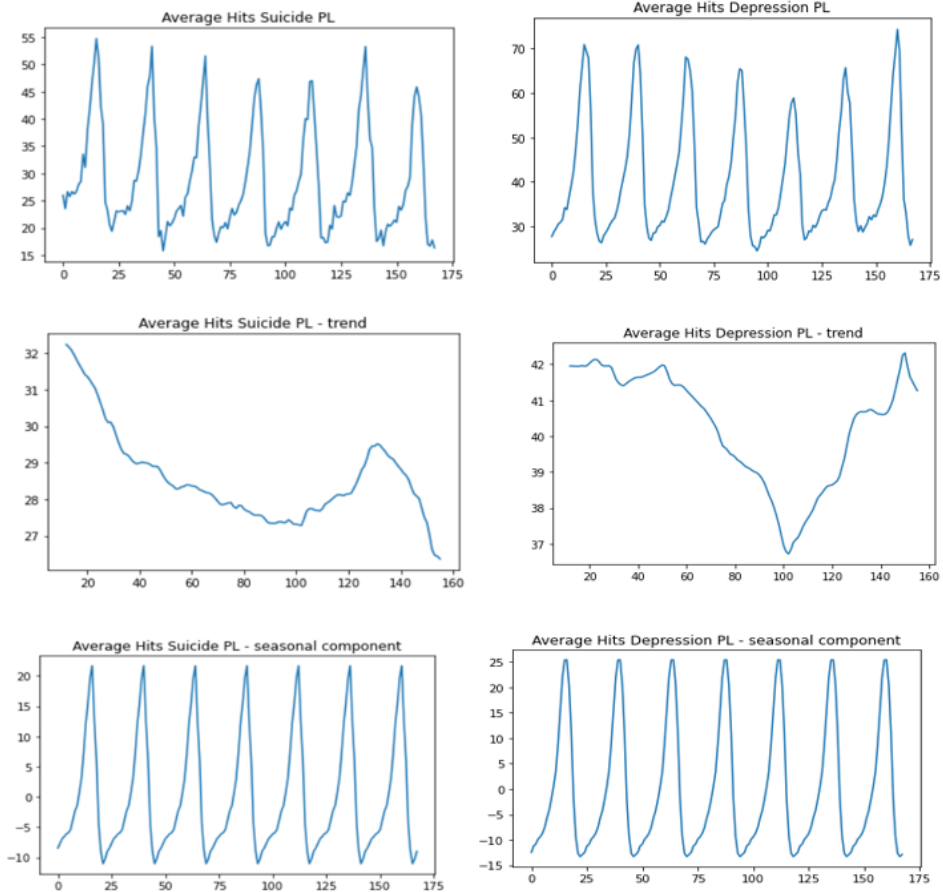
Figure 1. Hits “suicide” and “depression” for Poland–trend-seasonal